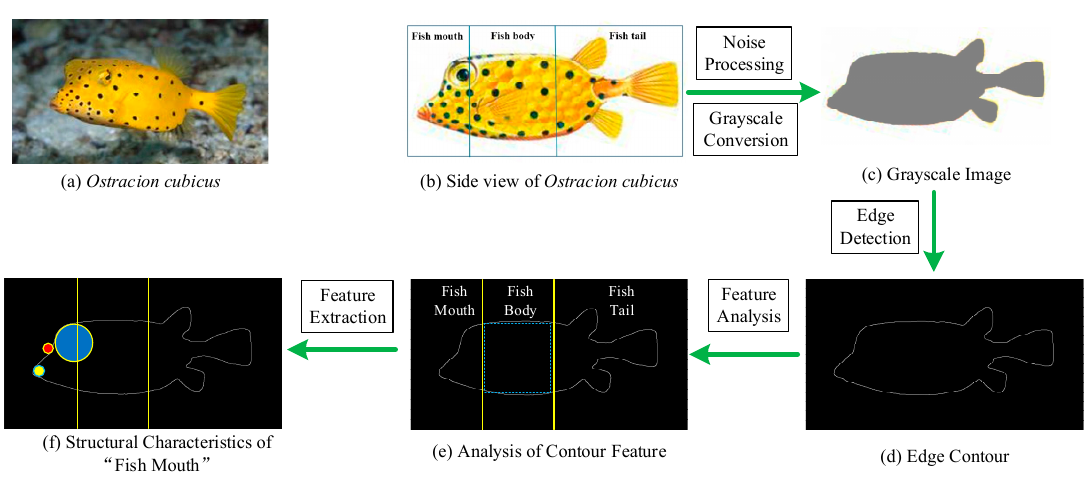
Figure 1. The geometry of the flow domain and boundary conditions.